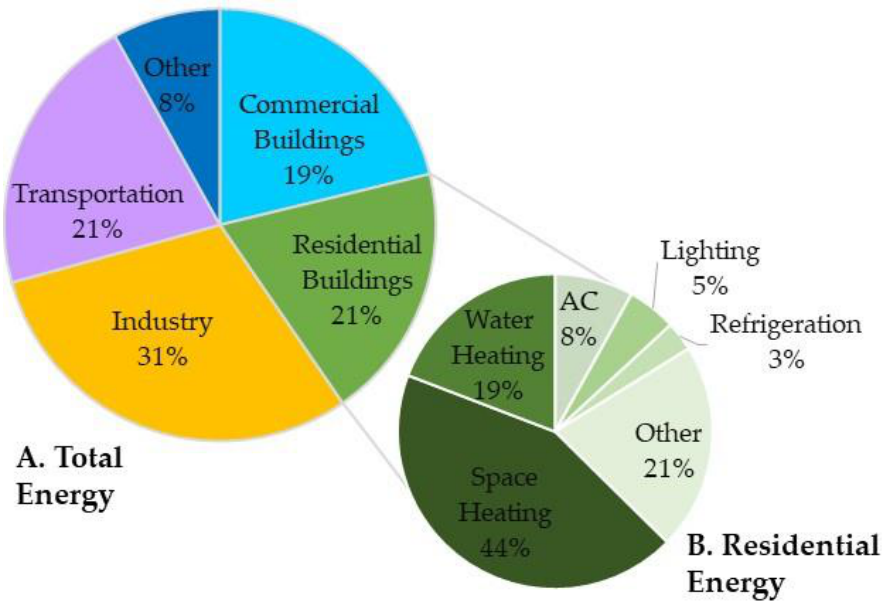
Figure 1. Breakdown of energy usage in the United States ( A ) by sector and ( B ) by end-use for residential buildings. Buildings use 40% of the total energy in the US with residential buildings being responsible for 21%, space heating for 44%, water heating for 19%, air conditioning for 8%, lighting for 5%, refrigeration for 3%, and the other 21% is the total energy used by residential buildings (data source: [3]).